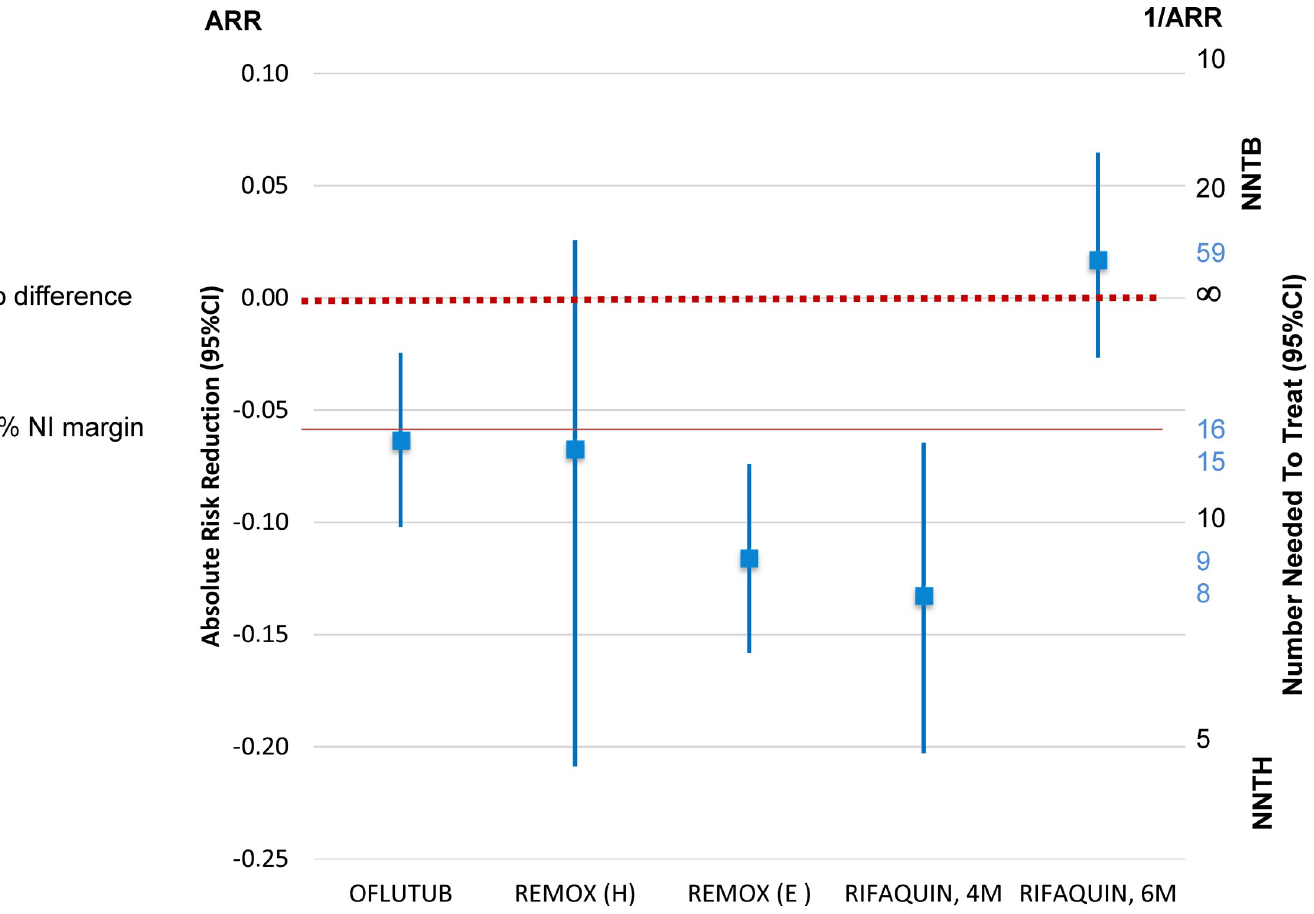
Fig 3. Fluoroquinolone-substitution trials in DSTB: 18 month rates of unfavourable outcome in the mITT population expressed as ARR between test versus control regimen and corresponding number needed to treat. ARR, absolute risk reduction; CI, confidence interval; DSTB, drug-sensitive tuberculosis; E, ethambutol; H, isoniazid; mITT, modified intent-to-treat; NI, noninferior; NNTB, number needed to treat for one patient to benefit; NNTH, number needed to treat for one patient to be harmed.